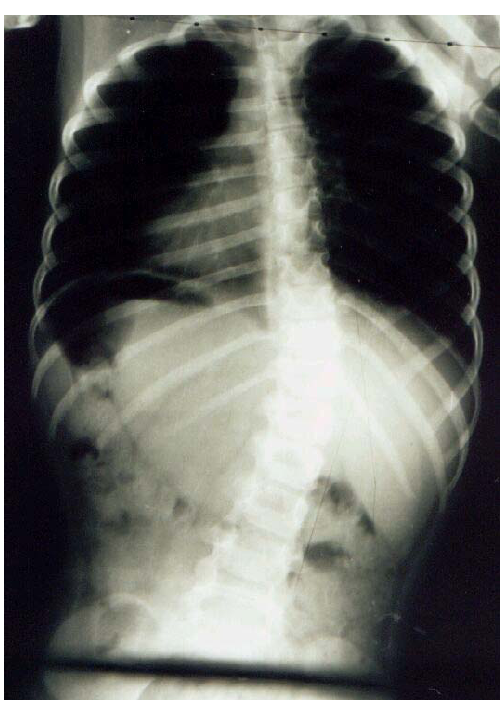
FIGURE 4. X-ray taken on February 16, 2000, in a suspended position showing 20º Cobb.